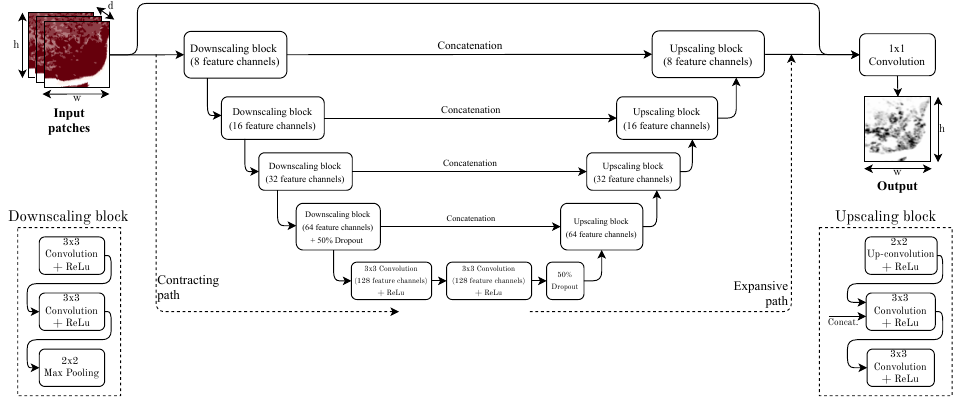
Figure 2. The adapted encoder–decoder deep neural network architecture.